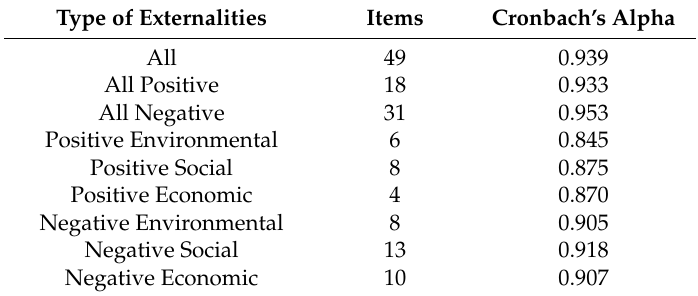
Table 3. Cronbach’s Alpha computation for different types of externalities considered ( n of experts = 15).